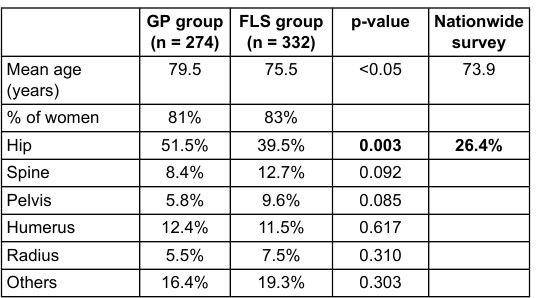
Table 1: Characteristics of the 606 patients included. Table 2: Dual X-ray absorptiometry results.